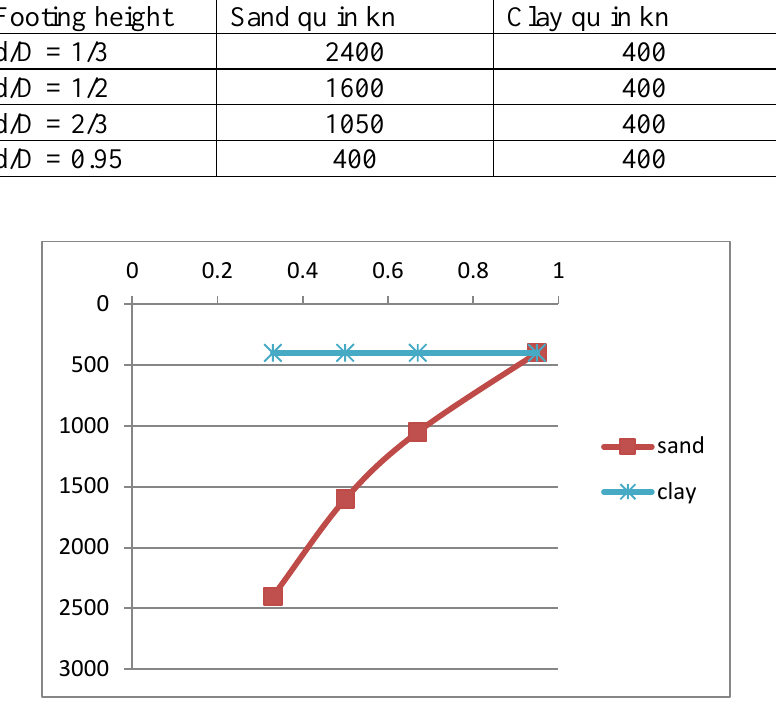
Fig. 7. Bearing Capacity ring Footing (d/D) ratio